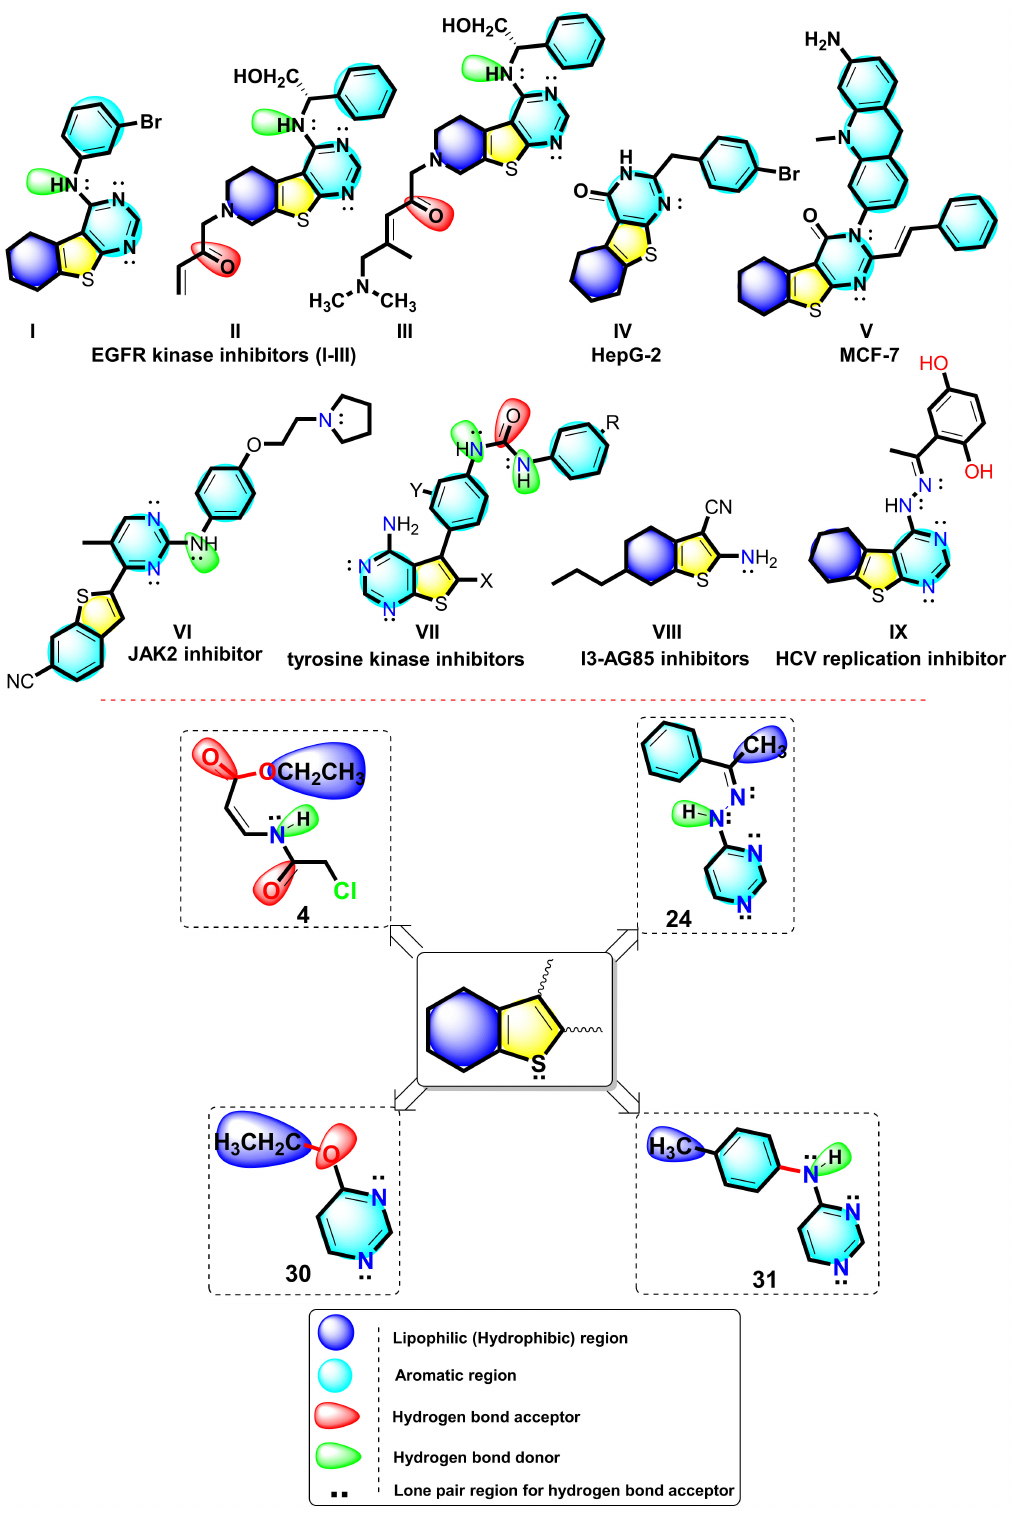
Figure 1. Biologically active compounds based on benzo[ b ]-thiophene and cycloalkyl[ b ]thiophene and pharmacophoric / functional groups